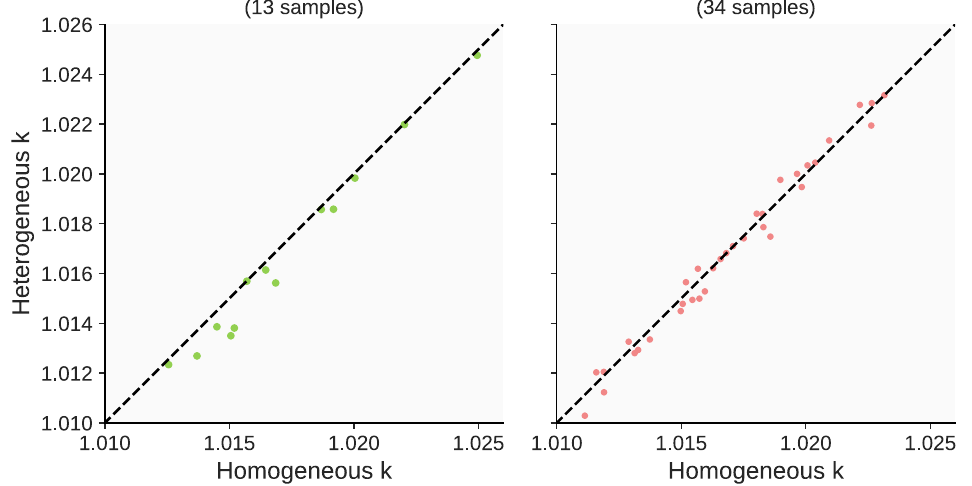
Figure 5: Comparison of experimentally-determined radial void distributions and their homogeneous equivalents. Distributions reflecting uniform pin powers (left) and distributions reflecting simulated pin powers